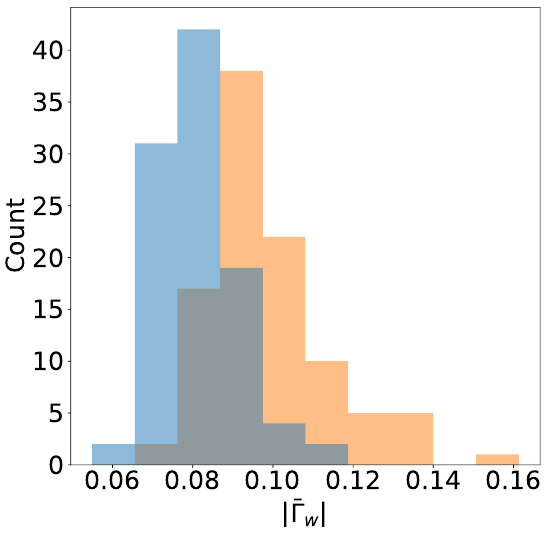
Figure 29 . Distributions of | ¯Γ w | for two populations of 100 pseudo-experiments each, and with N = 1000 points per pseudo-experiment. The blue histogram corresponds to data generated from the pure-background distribution (2.2) as in the left panel of figure 1. The orange histogram represents pseudo-experiments with added signal with a straight-line boundary as in the middle panel of figure 1, with the points sampled from (2.5) with ρ = 1 . 5 . In either case, the wombling measure ¯Γ[ C ] was computed throughout the ( p in , p out ) parameter space on an 80 × 80 grid and the √ best wombling line C w of minimum length 2 / 2 was identified following the procedure of section 7.